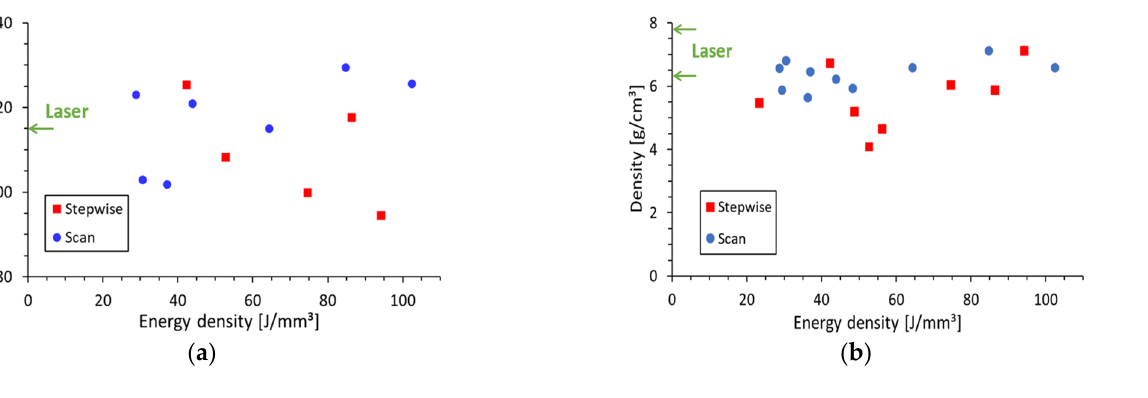
Figure 7. ( a ) Density and ( b ) hardness test results of scanning and stepwise LMH–AM products (as in Figure 5) vs. the spent microwave energy per unit powder volume (i.e., the energy density). The green arrows indicate typical laser-based AM specifications [50], as a benchmark.